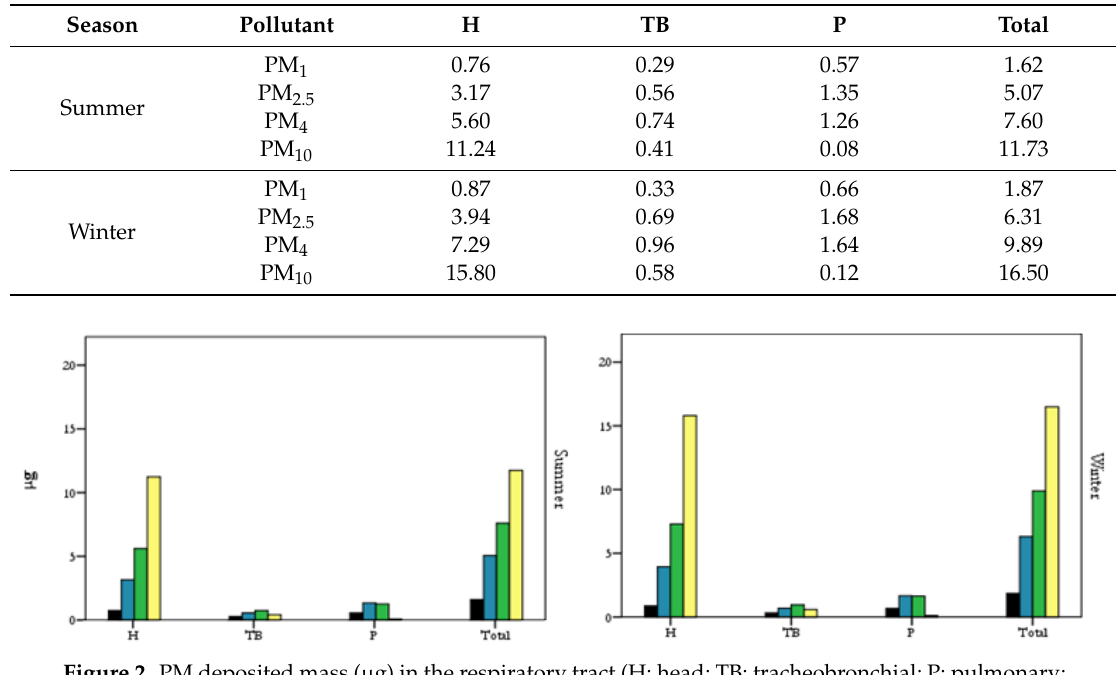
Table 2. Particulate matter (PM) mass values (µg) deposited in the respiratory tract during the monitoring period (8:00 a.m. to 3:00 p.m.) (sections: H: head; TB: tracheobronchial; P: pulmonary; total: H + TB + P).